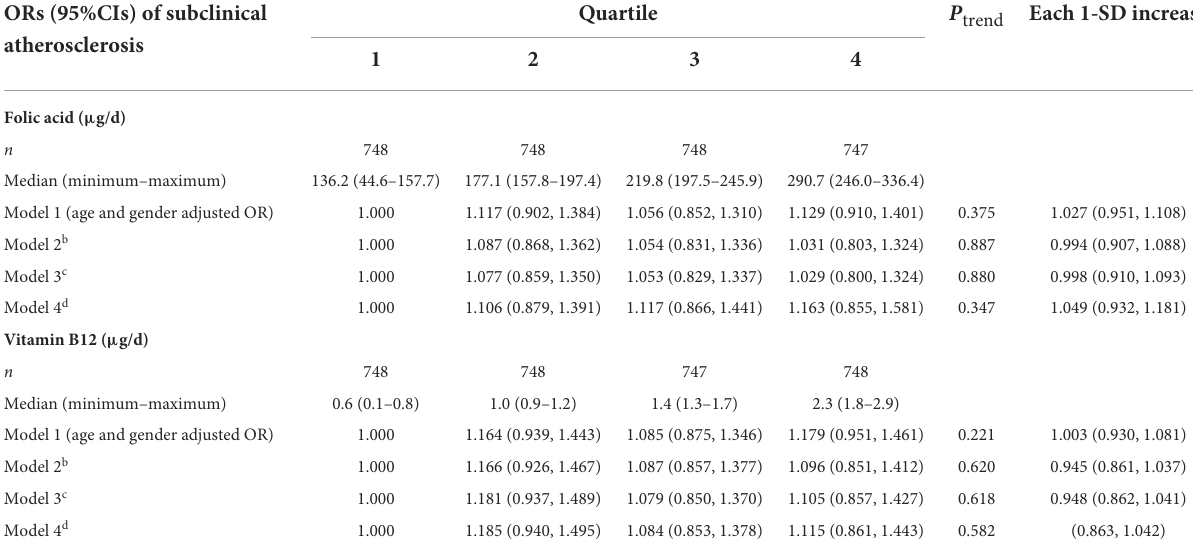
Quartile P trend